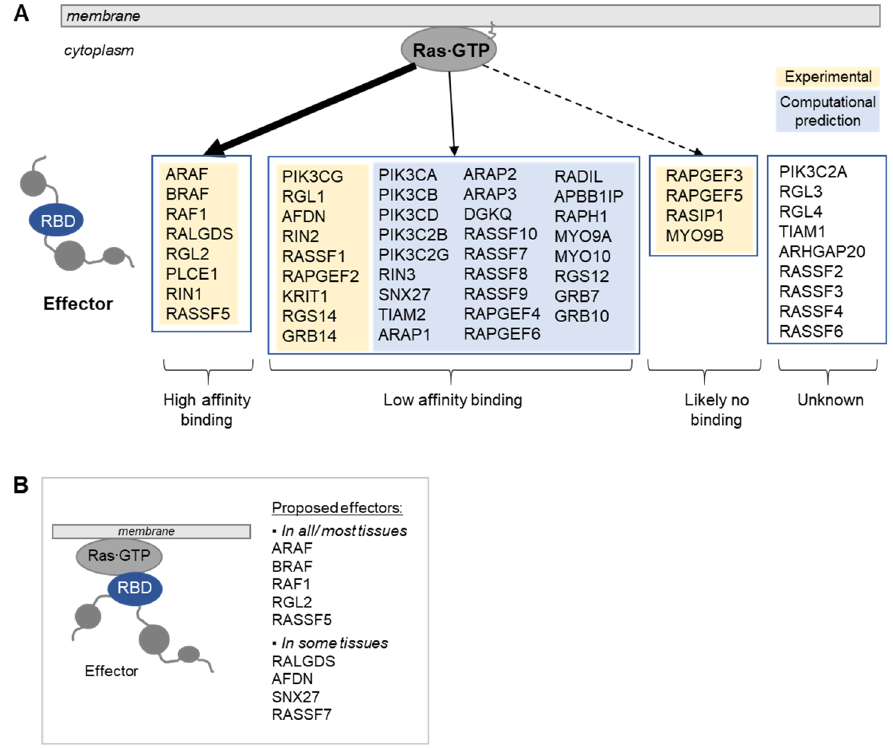
Figure 2. RAS and 56 classical effectors. ( A ) Classification of effectors based on the binding affinity of the RBD in complex with RAS∙GTP. High-affinity binders are defined by K d values of ≤1 μM, and low-affinity binders by K d values of >1 μM). ( B ) Schematic representation of the recruitment of effectors to RAS∙GTP via their RBD. Five effectors are predicted to be recruited efficiently to RAS∙GTP via their RBD only in all/most of the 29 human tissues, and four effectors are predicted to be recruited efficiently to RAS∙GTP via their RBD only in some of the 29 human tissues [23].